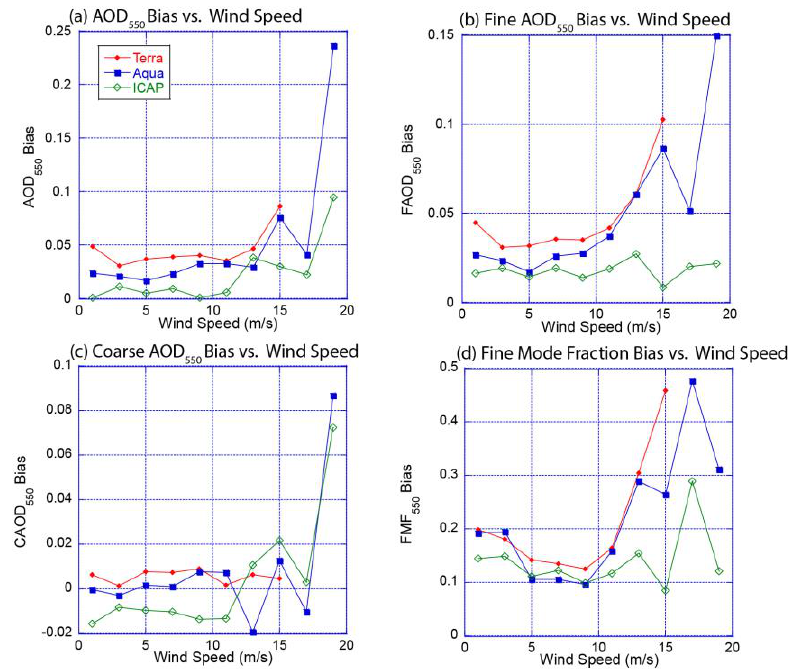
Figure 12. Diagnostic mean bias of ( a ) Total, ( b ) Fine, and ( c ) Coarse aerosol optical depth for Terra MODIS, Aqua MODIS, and the ICAP C4C as a function of surface wind speed, and ( d ) mean bias for fine mode fraction ( η 550 ) as a function of surface wind speed.